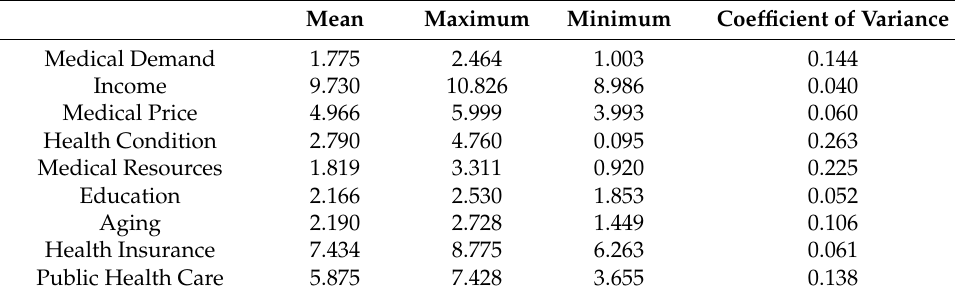
Table 2 outlined the summary statistics for all variables. Table 2. Summary statistics of